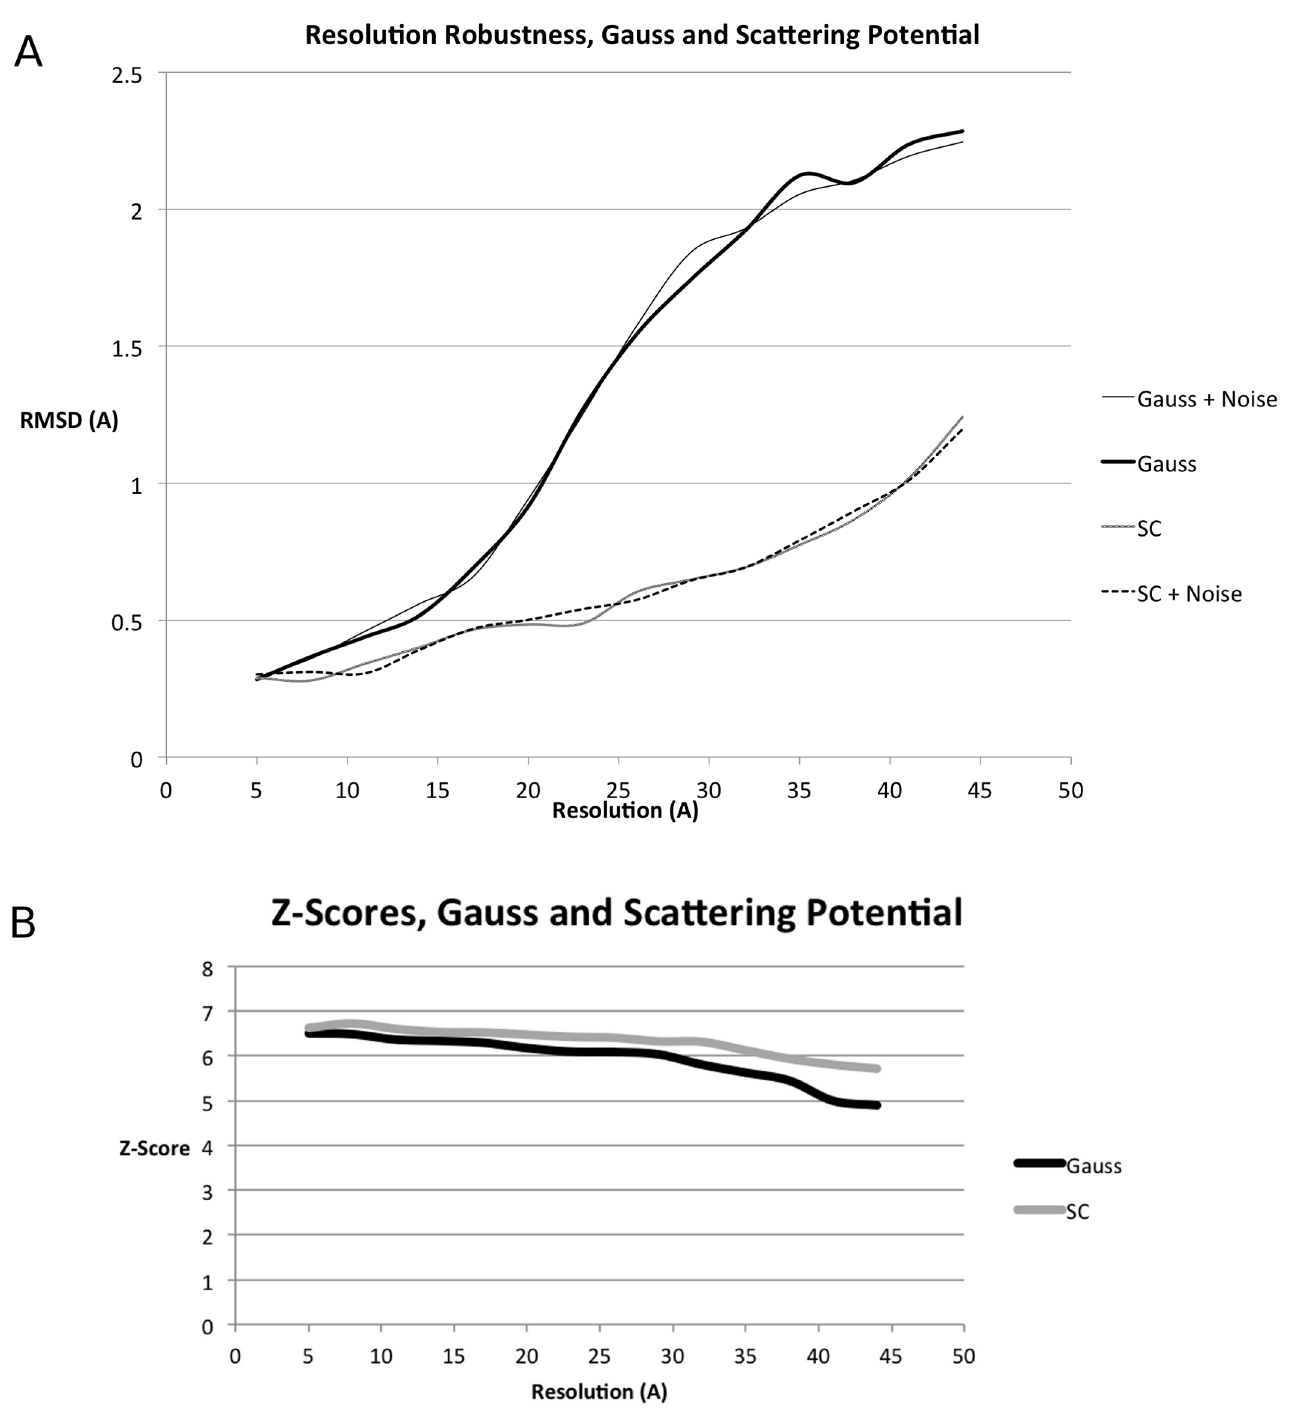
Fig 5. Resolution robustness and comparison of scattering potential (SCCS) and Gaussian (GCCS) scores for synthesized data. We plot the RMSD of the top-ranked result as a function of the resolution of the EM map used for the fit. See the section titled “ Dataset ” for a list of PDBs used in this experiment. (A) Average resolution-dependent RMSD of the top-ranked result returned by PF 2 fit — SE(3) in the absence and presence of noise for the GCCS and the SCCS. (B) Average Z-Score for the ten top results in the absence of noise. Z-Scores in the presence of noise follow the same trend.